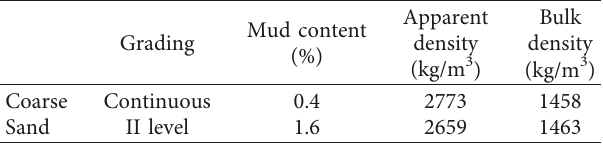
Table 3: The properties index of coarse and fine aggregates of concrete.